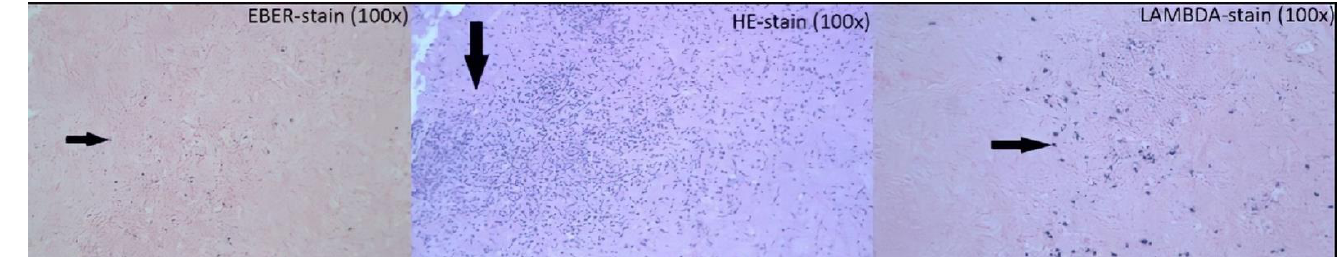
Figure 5. PTLD of the brain. Brain tissue with atypical lymphoplasmacytic infiltrate (arrow), H&E stain 100x. The plasma cells are lambda restricted (arrow), consistent with lymphoproliferative disorder (in situ hybridization stain for lambda, 100x). In situ hybridization for EBER shows scattered positive lymphocytes (arrow), which supports the diagnosis of post-transplant lymphoproliferative disorder PTLD (100x).